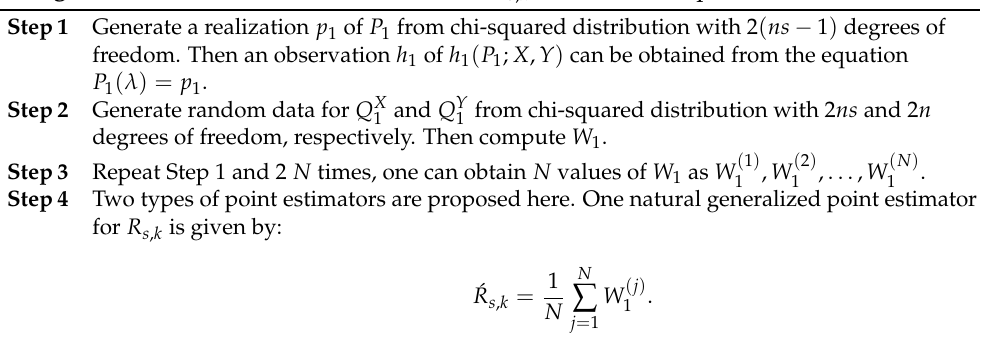
Algorithm 1: Pivotal based estimation for R s , k with common